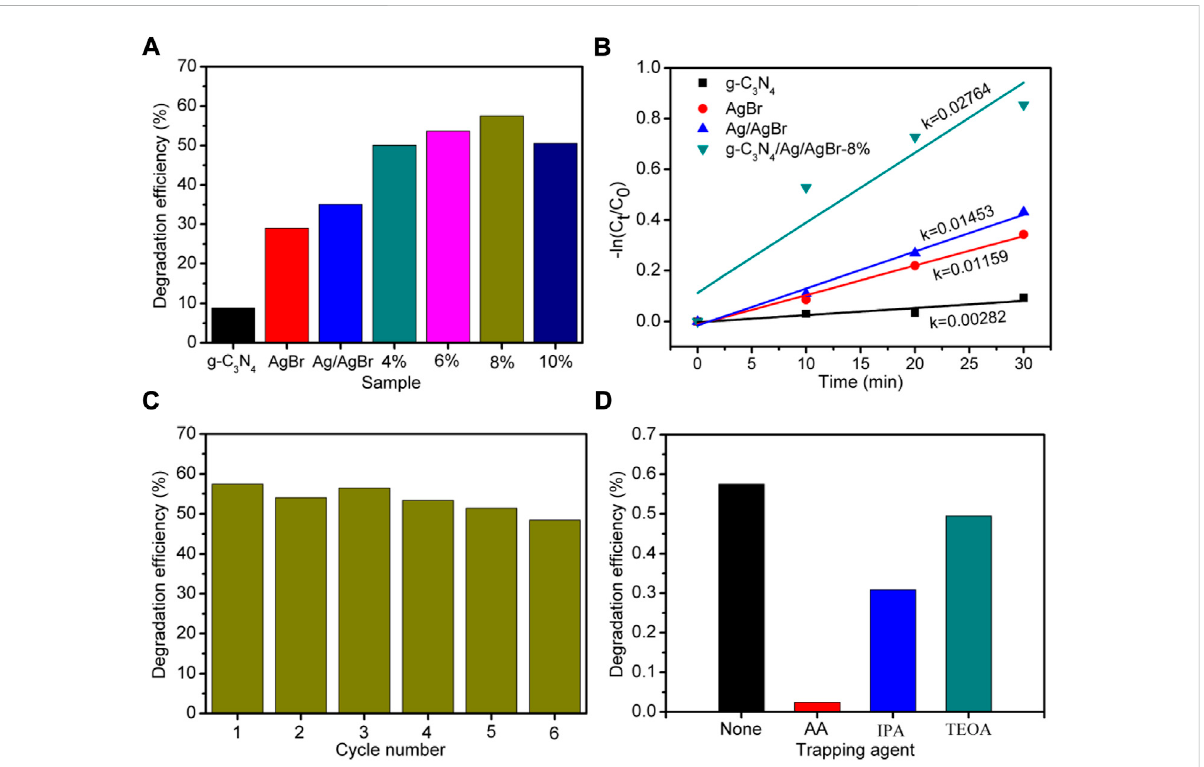
FIGURE 7 (A) Photodegradation ef fi ciency of tetracycline hydrochloride using g-C 3 N 4 , AgBr, Ag/AgBr, and g-C 3 N 4 /Ag/AgBr as photocatalysts in 30 min.